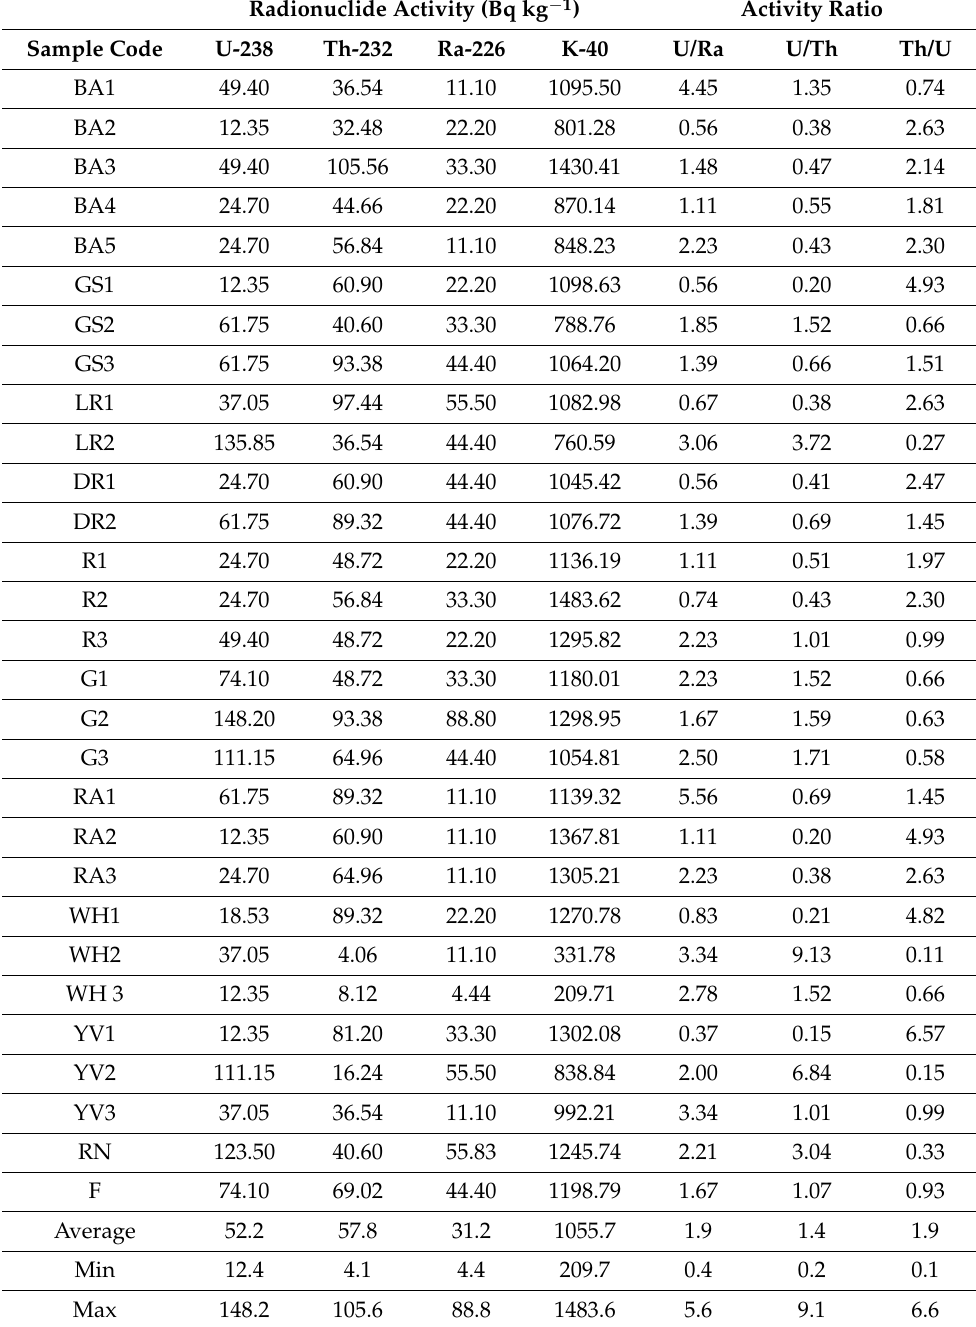
Table 1. Activity concentrations of 238 U, 226 Ra, 232 Th and 40 K (Bq kg − 1 ) and ratios for the studied granite